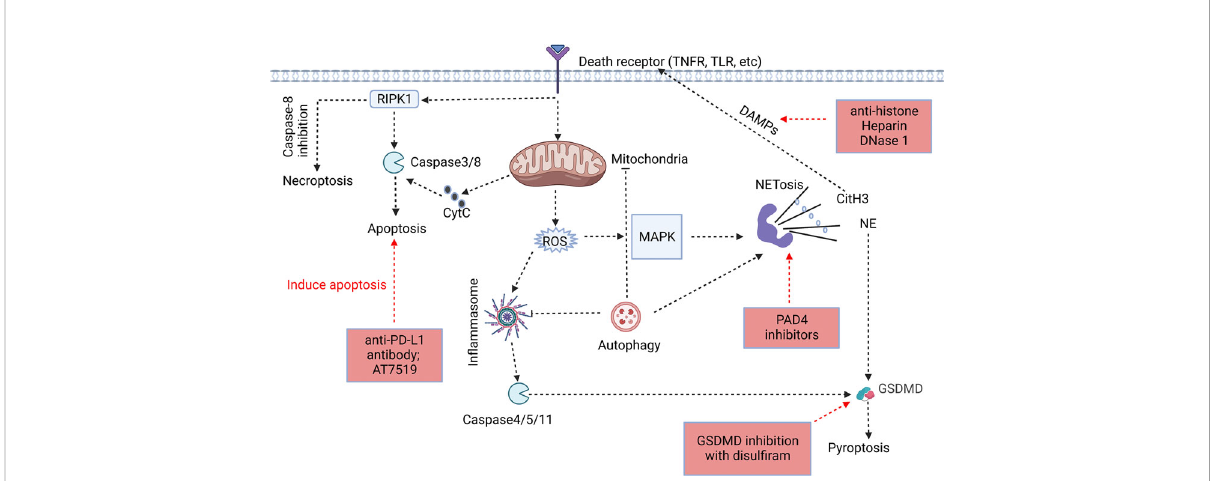
FIGURE 1 Association of different forms of programmed neutrophil cell death. The forms and speci fi c mechanisms about neutrophil cell death in sepsis are not clear. Neutrophil apoptosis is delayed in sepsis, and necroptosis may occur when caspase-8 activity is inhibited. Neutrophils may release NETs through NETosis, and CitH3 in NETs may cause cell death as DAMPs. GSDMD, a key protein in pyroptosis, is involved in the release of NETs, and NE in NETs has the ability to cleave GSDMD to cause pyroptosis. Autophagy, as an intracellular degradation system, can recover harmful substances in cells and prevent the spread of in fl ammation, but it may assist in the formation of NETs despite of the ongoing controversy (32, 34 – 36). The process of cell death usually begins at the receptor itself. However, the signaling cascade determines the fate of neutrophils to some extent. In addition, we summarized the therapeutic potential strategies of neutrophil death for sepsis, including induction of neutrophil apoptosis, GSDMD inhibition, anti-NETosis, and anti-DAMPs (Red